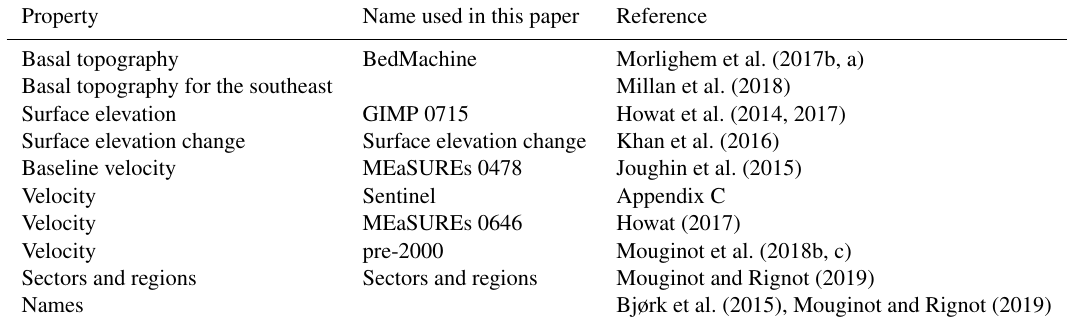
Table 1. Summary of data sources used in this work.